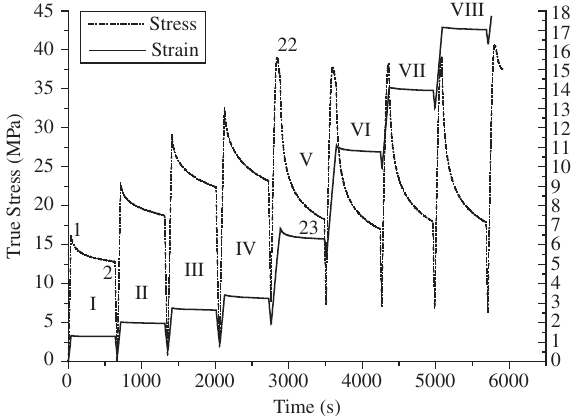
Figure 14. Stress-strain-time curves with cycles for stress relaxation.